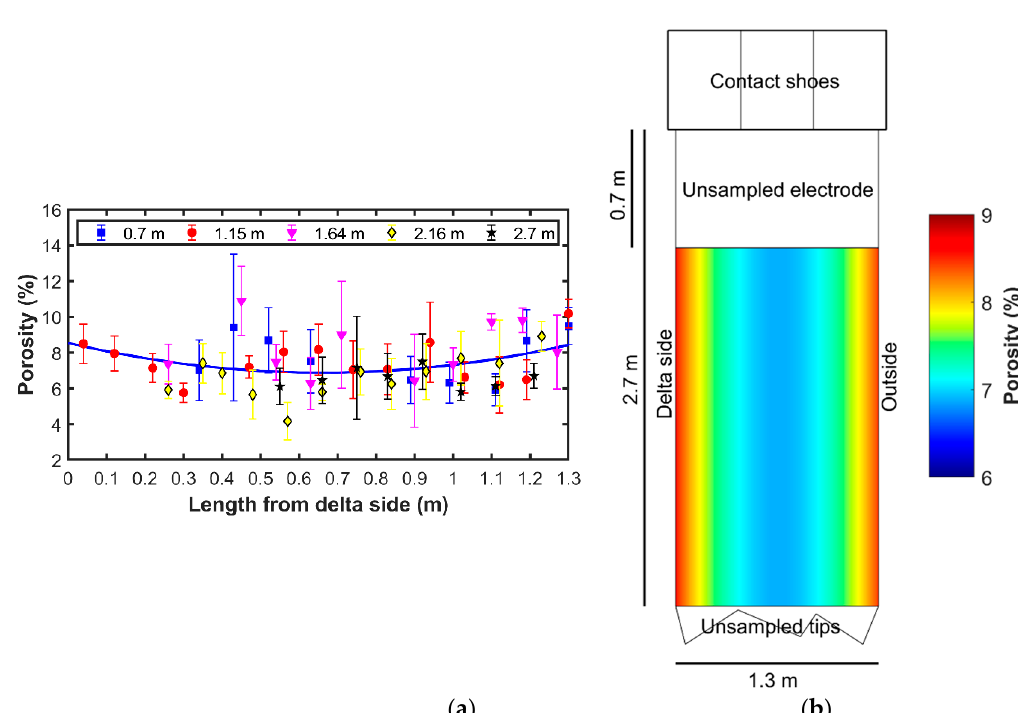
Figure 8. ( a ) Average measured porosity (markers), as a function of length below the contact shoes and distance from the delta side of the electrode, as well as a single 2nd order polynomial fit of this data (line); ( b ) 3D rendering of the fitted line data associated with porosities at 10 mm intervals across the electrode at each of the lengths below the contacts shoes indicated in Figure 8a.